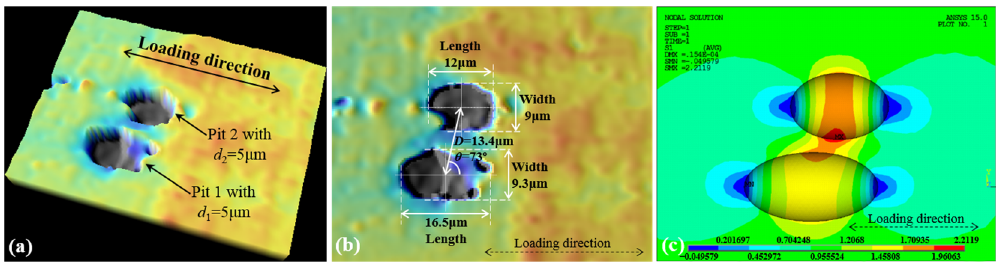
Figure 16. An example for corrosion characterization and the FEA (finite element analysis) result of the C-SCF. ( a ) 3D morphology; ( b ) 2D morphology with pit dimensions; and ( c ) the FEA result for the C-SCF.